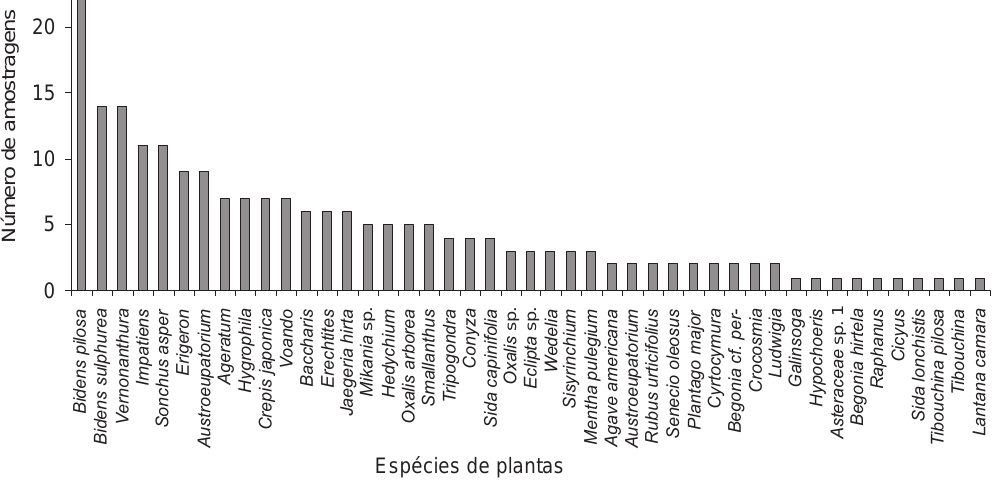
Figura 2. Espécies de plantas e frequência de visitas por abelhas em São Bento do Sul. Espécimes em vôo foram incluídos sob a denominação